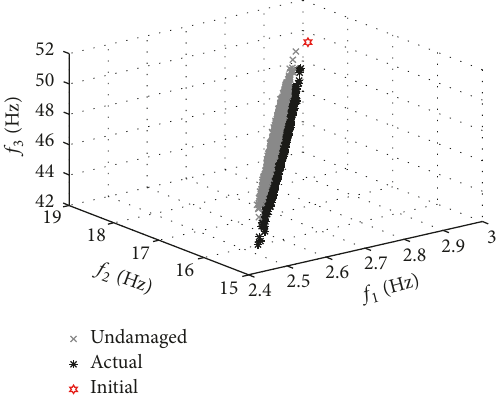
Figure 2: First three actual modal frequencies set (3000 samples) and initial modal frequencies (thickness).